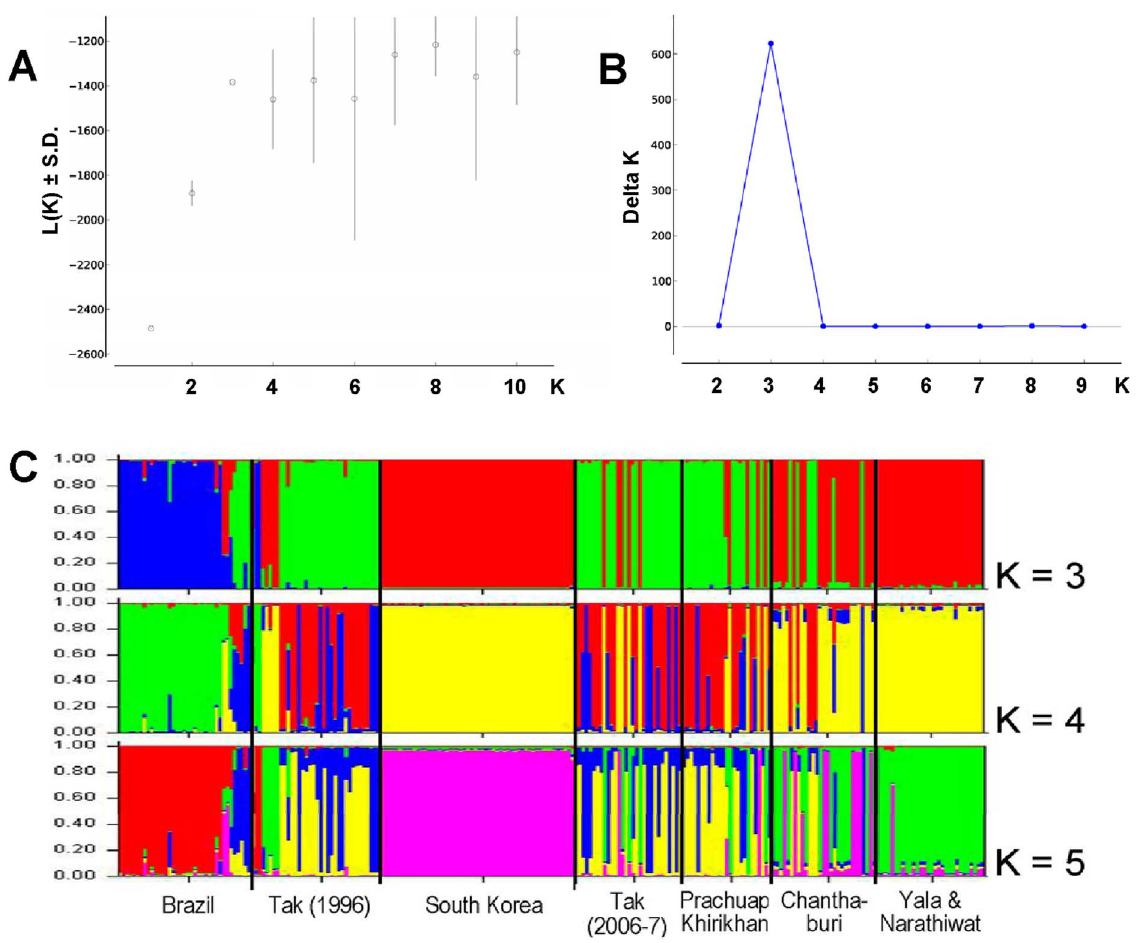
Figure 1. Determination of the most likely number of clusters of PvTRAP haplotypes by adhoc methods: (A) relationship between K and mean of estimated mean log likelihood of K and its standard deviation or L(K) ± S.D. [45], (B) relationship between K and delta K [46]. (C) Graphical representation of the genetic structure of populations from Brazil, South Korea and each endemic area of Thailand. Results are given for K3, K4 and K5.